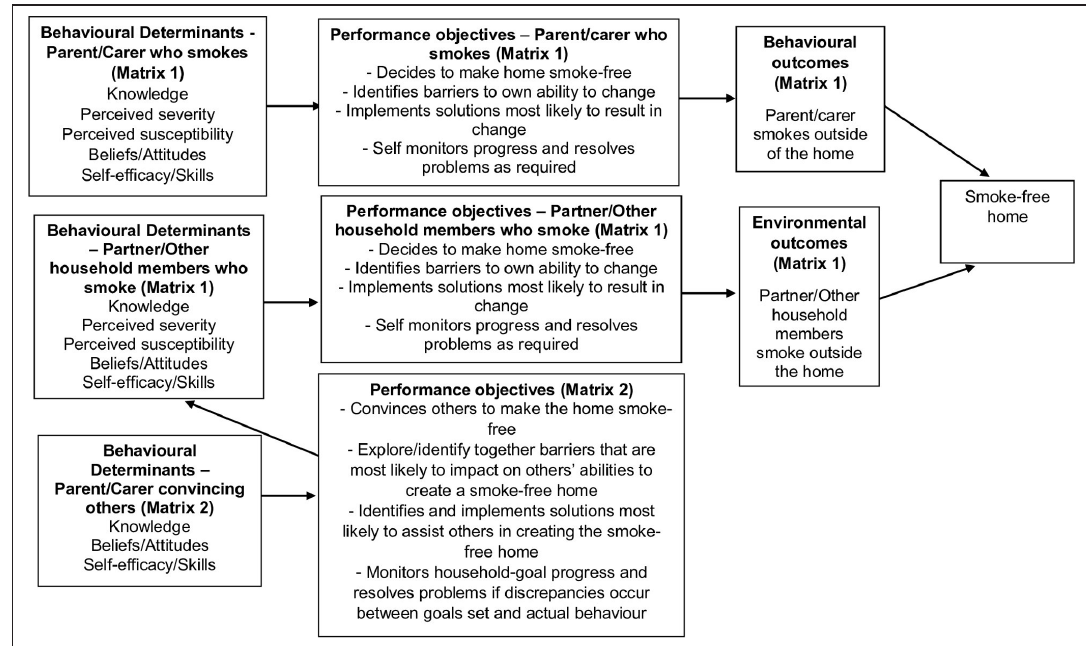
Figure 3: Logic model of